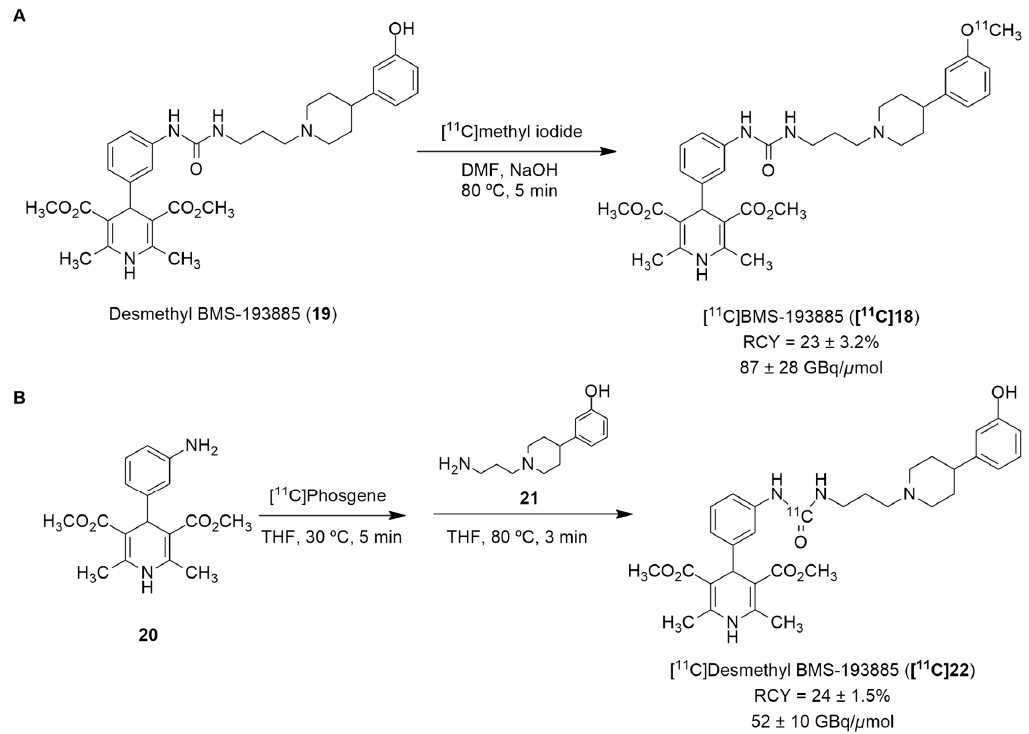
Figure 8. Radiosynthesis of [ 11 C]19 via [ 11 C]CH 3 I ( A ) and [ 11 C]22 via [ 11 C]phosgene ( B ).